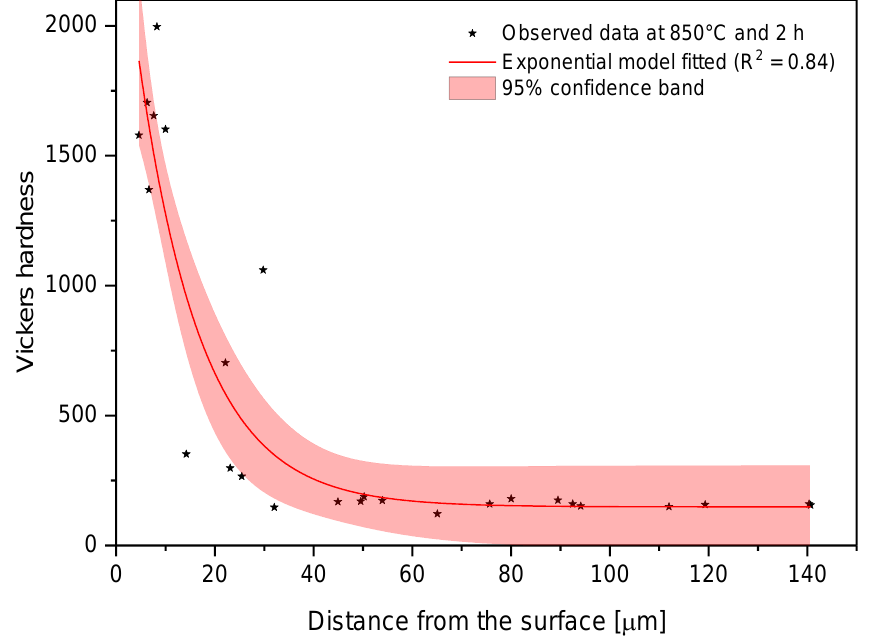
Figure 8. Changes in microhardness as measured away from the surface for a sample treated at 850 °C and 2 h.